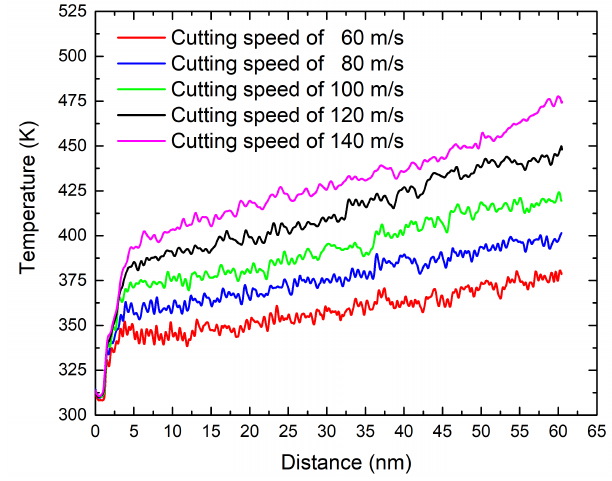
Figure 11. Workpiece temperature of cutting with different cutting